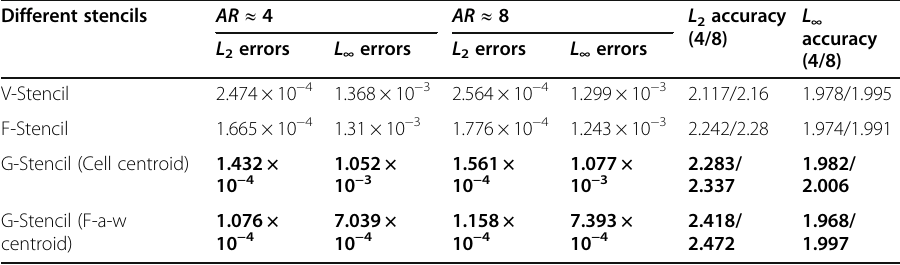
Table 6 Computational errors on the finest grid and L 2 , L ∞ accuracy between the last two grids of different stencils